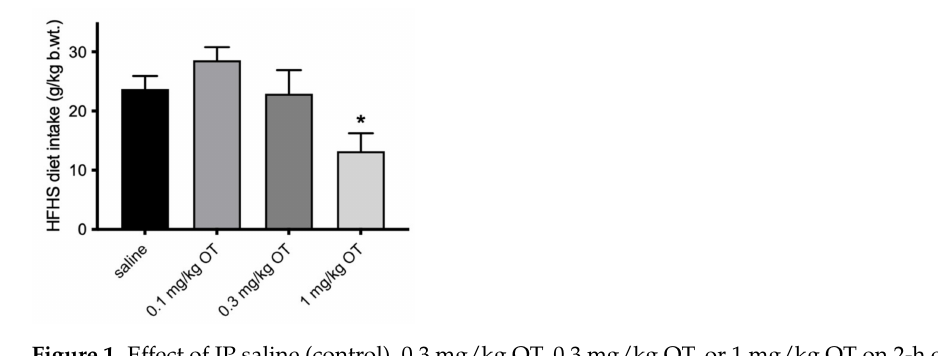
Figure 1. Effect of IP saline (control), 0.3 mg/kg OT, 0.3 mg/kg OT, or 1 mg/kg OT on 2-h episodic intake of energy-dense and palatable HFHS chow in nondeprived rats. * p < 0.05 (significantly different from saline